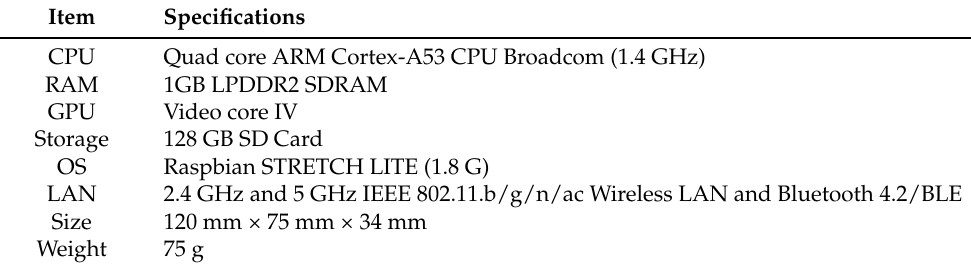
Table 2. PCB performance table for testing